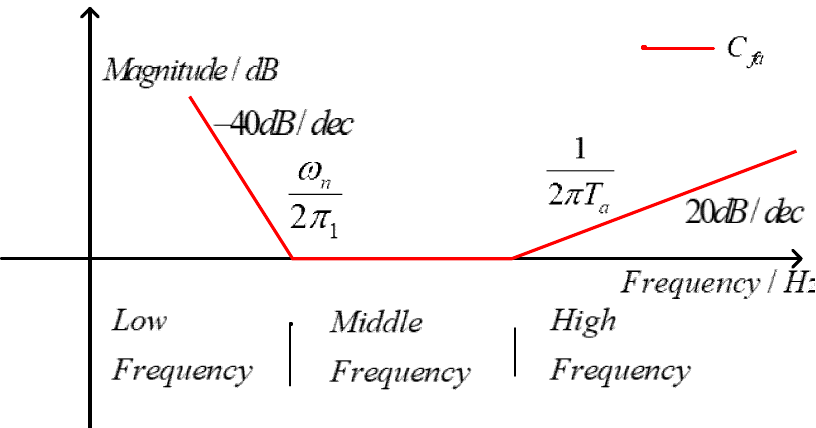
Figure 4. Bode diagram of the ideal acceleration-loop disturbance compensator.